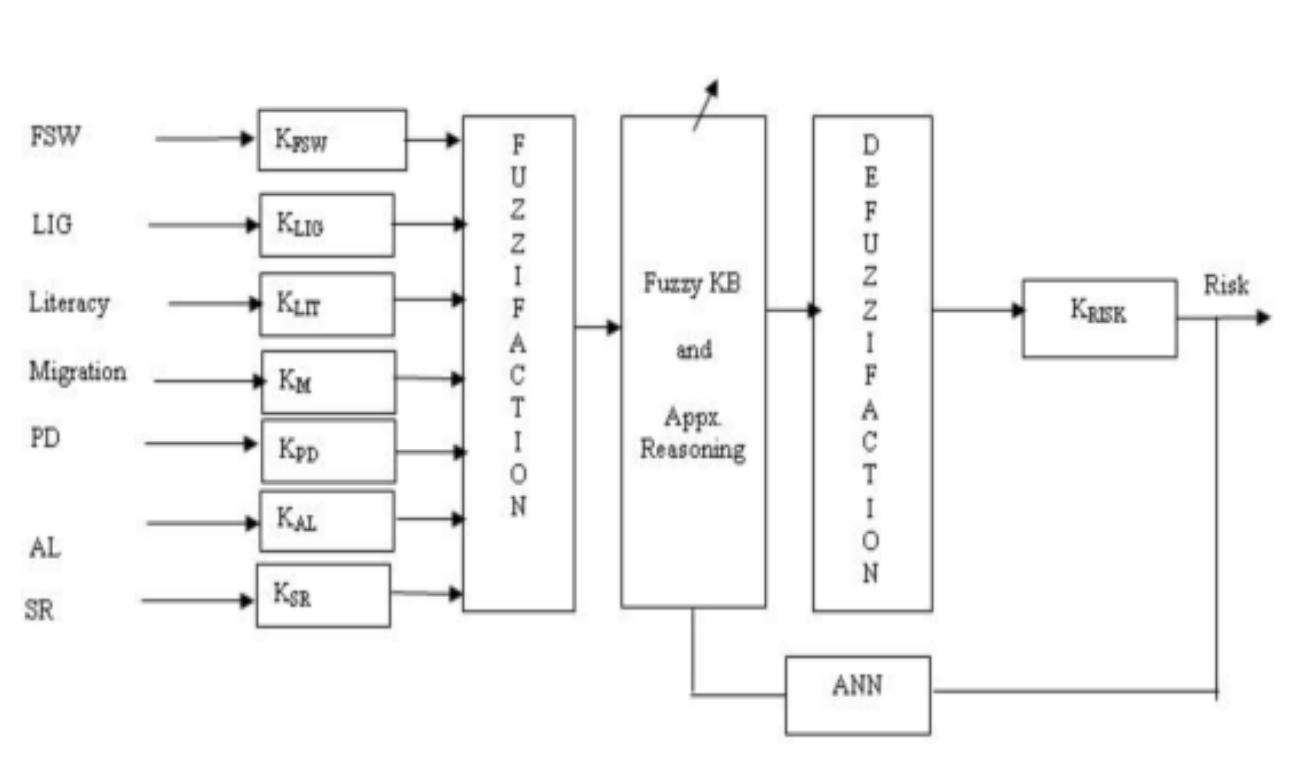
Figure 8: Block diagram of ANFIS model of